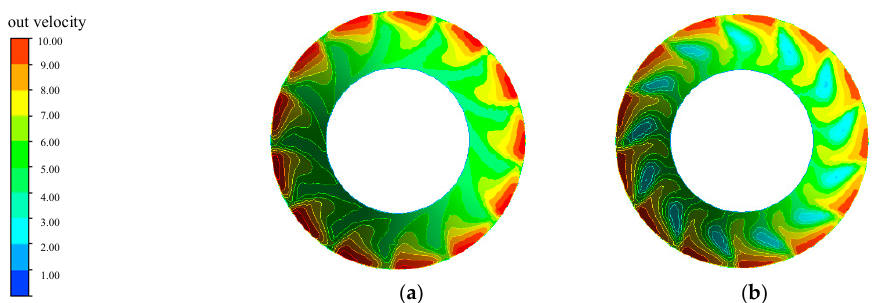
between the straight line and the parabolic line at the band): ( a ) ND B = 0.55; ( b ) ND B = 0.75; ( c ) ND B =